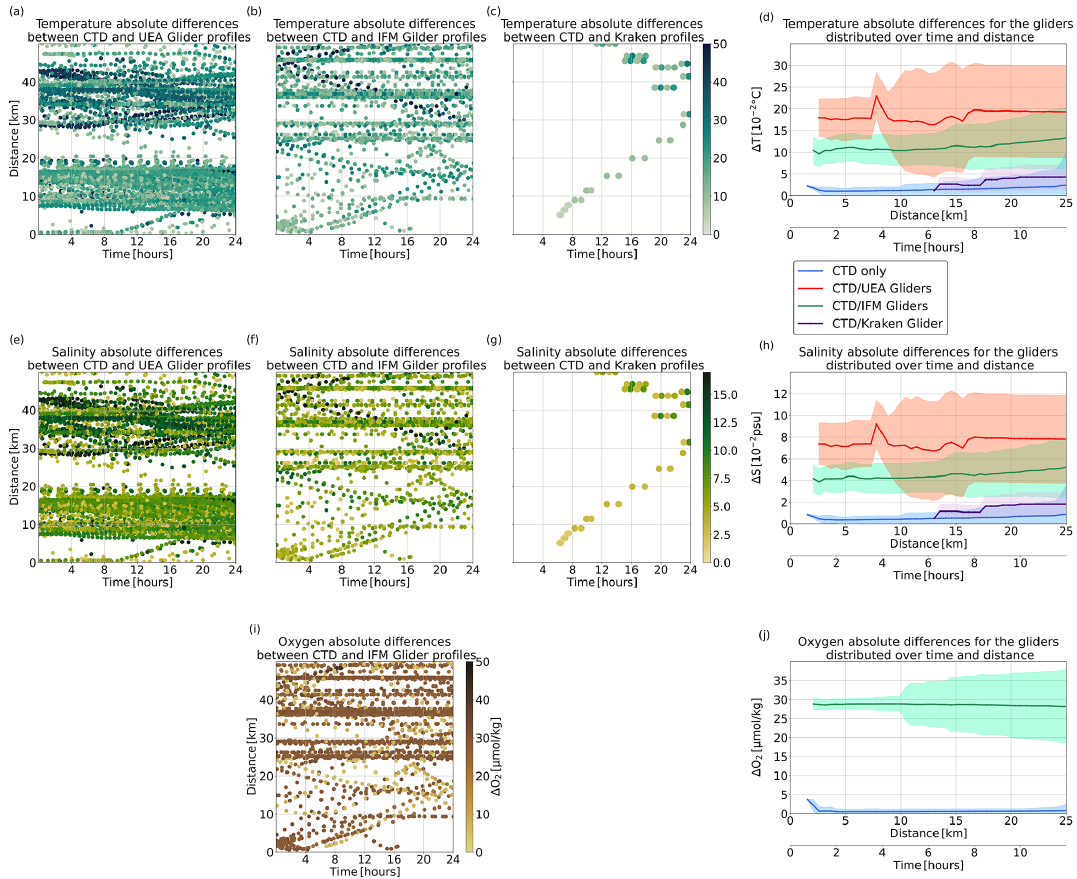
Figure 15. Panels (a) , (b) , and (c) show the temperature absolute differences between CTD/glider pairs of profiles on isopycnal levels, averaged and vertically distributed in time and distance. Each pair is composed of one CTD and one glider profile. Respectively, panels (a) , (b) , and (c) correspond to the UEA, IFM, and Kraken gliders. (d) Temperature differences as a function of time and distance for pairs of profiles. The differences are shown in blue for pairs of CTD-only profiles, in red for pairs composed of one CTD and one UEA profile, in green for pairs composed of one CTD and one IFM profile, and in purple for pairs composed of one CTD and one Kraken profile. The middle line of panels (e) to (h) is the same as above but for salinity absolute differences. The bottom line of the panels correspond to oxygen absolute differences, but only IFM gliders measured dissolved